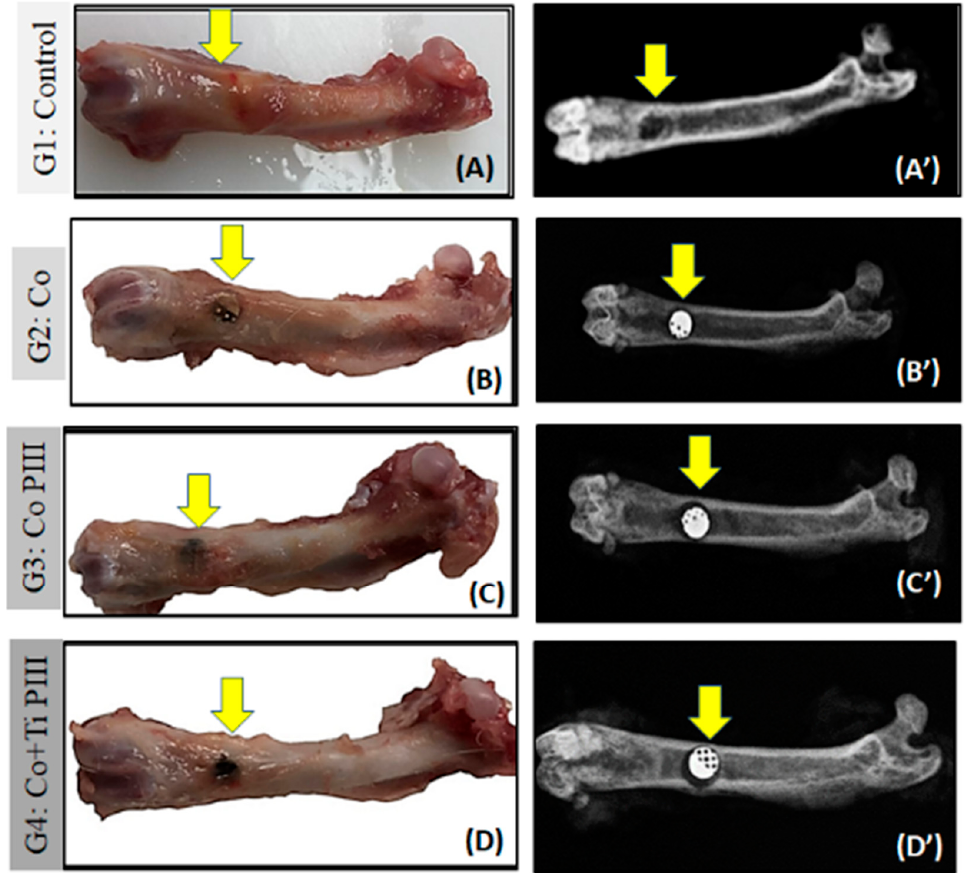
Figure 4. Evaluation of macroscopic features ( A – D ) and X-ray ( A’ – D’ ) of defects in the femur bone rats (arrows). Groups: G1: Control—no implant; G2: Co—Co-28Cr-6Mo alloy; G3: Co PIII- Co-28Cr-6Mo with surface nanostructured by PIII;